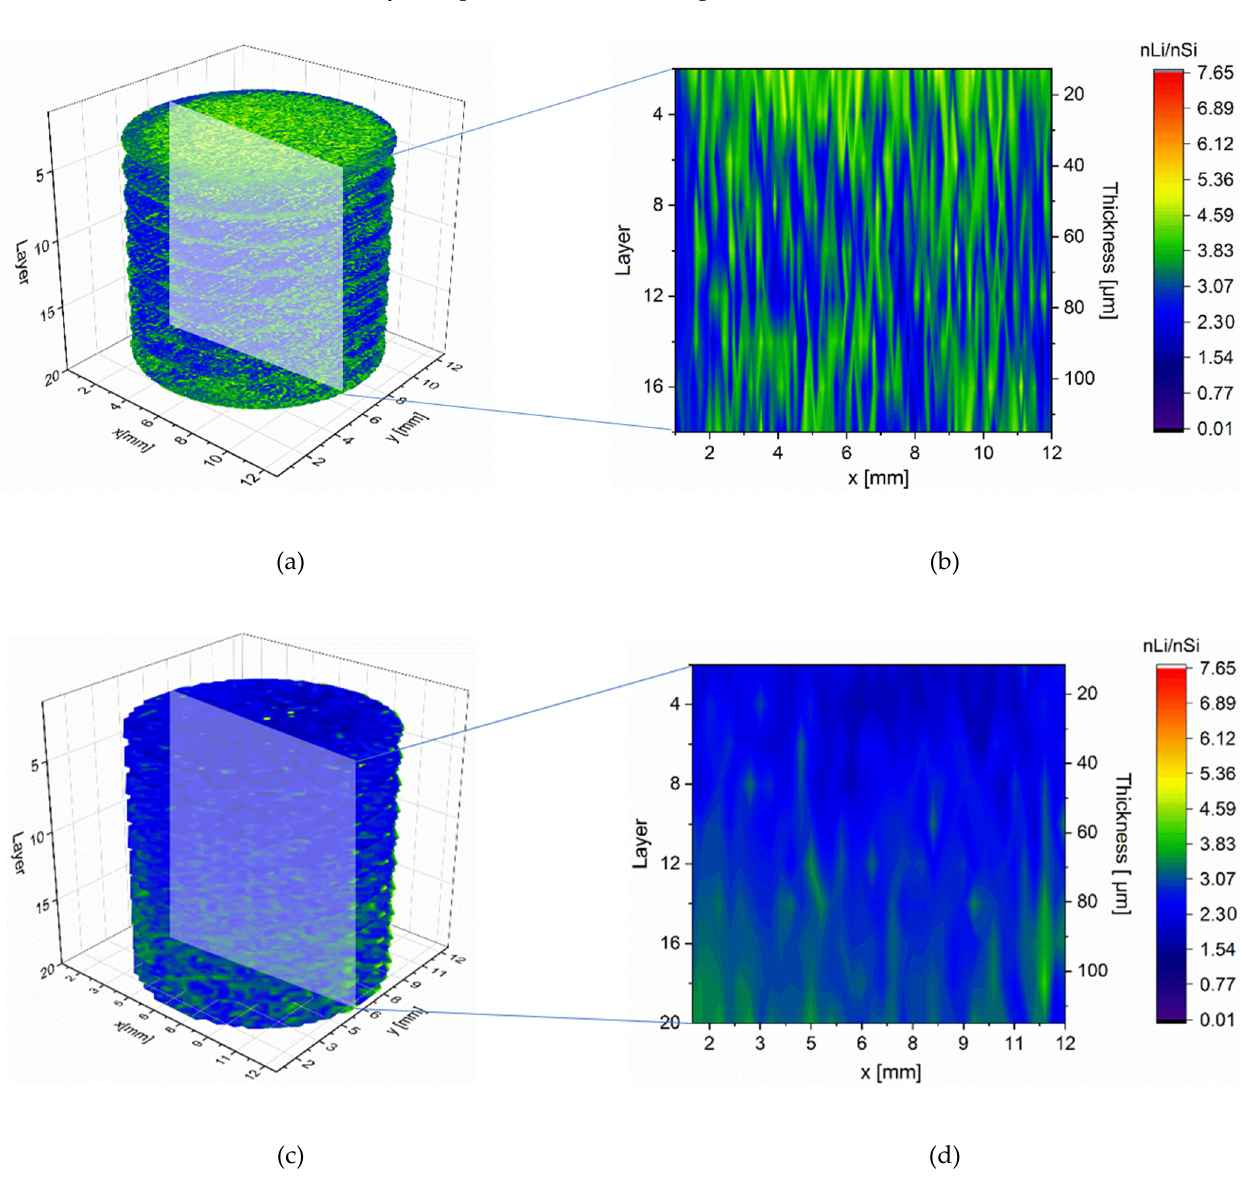
Figure 8. Lithium concentration profile in entire structured and unstructured Si/C electrodes delithi- ated by 1C: ( a ) 3D illustration of lithium concentration in a reference electrode, ( b ) its lithium distribution in the cross-sectional view, ( c ) 3D illustration of lithium concentration in a structured electrode (structure distance: 300 µm), and ( d ) its lithium distribution in the cross-sectional view. The achieved results indicate that laser-generated 3D electrodes can accelerate the lithium-ion transport during the lithiation and delithiation process and thereby realize the fast charging with reduced capacity loss. The lithium diffusion pathways established at a high C-rate (1C) were further investigated in detail using electrodes with micropillar structures. The cells with model electrodes (see Figure 1) were prepared in the identical way (Table 3). The micropillars were ablated layer-by-layer by LIBS laser pulses with 100 µm offset. The lithium distribution in a selected micropillar lithiated with 1C is presented in Figure 9. From the cross-sectional view (Figure 9a), it is obvious that a lithium enrich- ment with values nLi/nSi > 6 was located along the contour of the micropillar. Layer 6 of the horizontal cross-section (Figure 9b) revealed a minimum lithium concentration in the center of the micropillar. Oumellal et al. [10] describe how lithium-ions diffuse from the separator via the pores inside the electrode filled with liquid electrolyte into the particles. The LIBS measurements